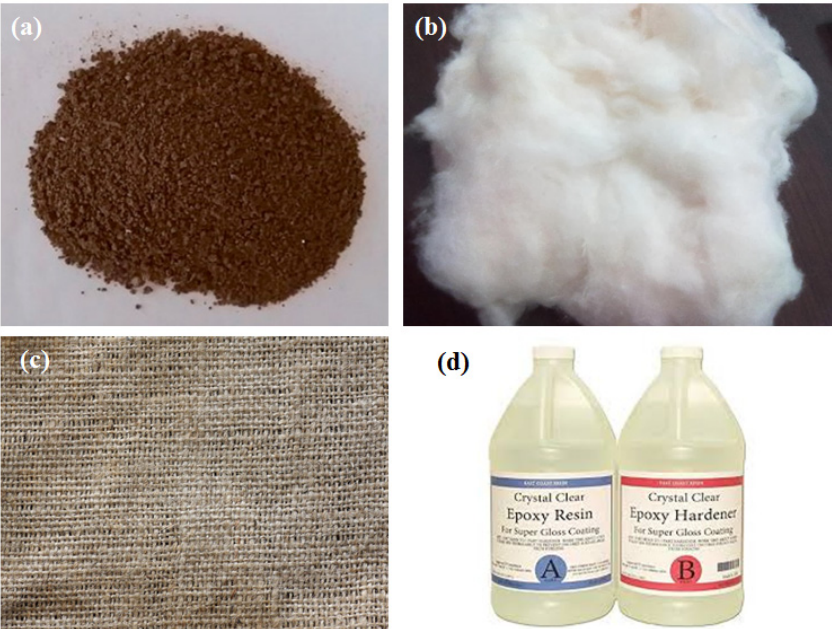
Figure 1. ( a ) Spent tea leaves, ( b ) cotton, ( c ) jute, and ( d ) epoxy resin and hardener.